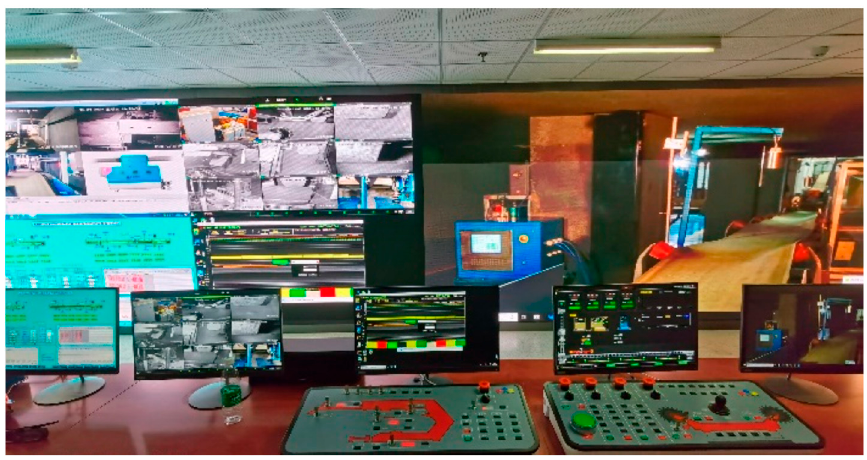
Figure 21. Schematic diagram of intelligent video surveillance technology (Reprinted from Ref.